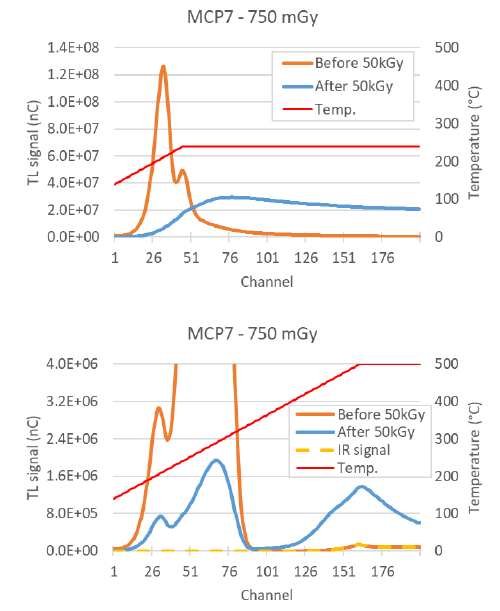
Fig. 7. Luminescence curves MCP7 TLDs before and after 50 kGy exposure. Measurement after a 750 mGy irradiation in front of a 60 Co source Top: constructor readout protocol, bottom: test readout